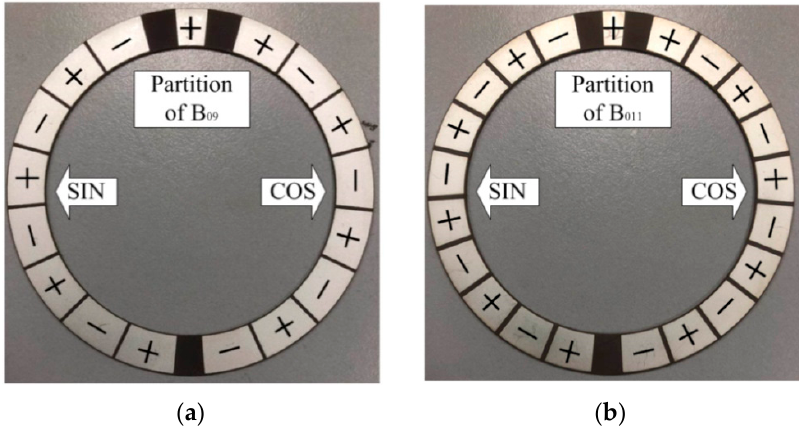
Figure 5. Different polarization partitions of PZT piezoelectric ceramics corresponding to different modes: ( a ) B 09 and ( b ) B 011 .